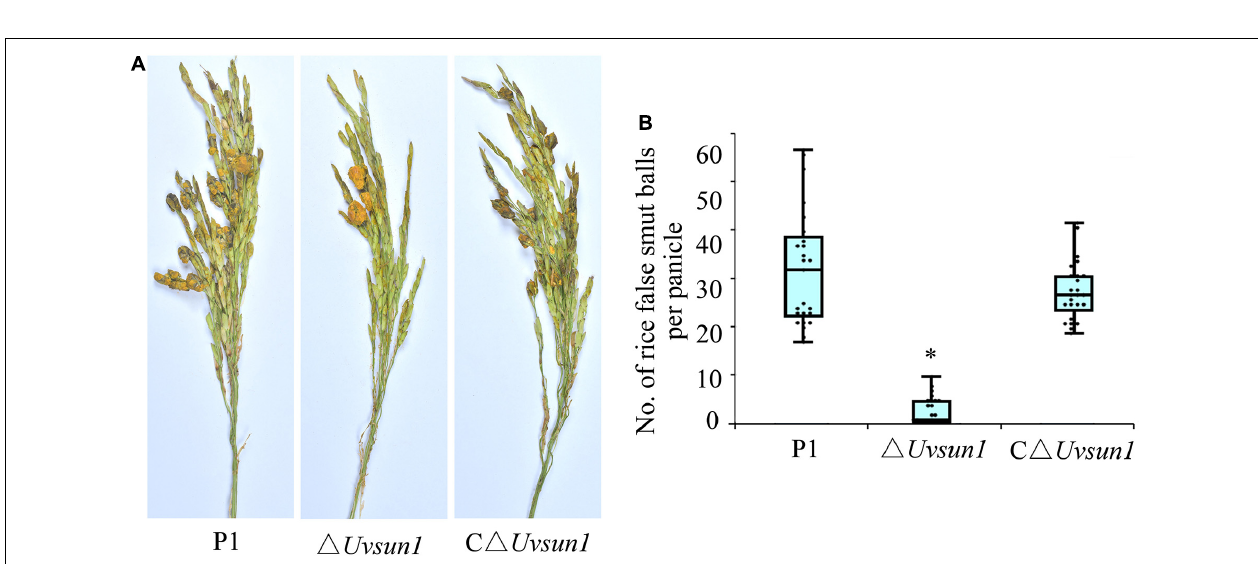
FIGURE 5 | Uvsun1 is required for Ustilaginoidea virens full pathogenicity in rice. (A) Rice spikelets were infected with an inoculum of P1, (cid:77) Uvsun1 and C (cid:77) Uvsun1 strains. Pictures were taken 21 days post-inoculation. (B) Quantification of false smut balls per infected panicle. The data were collected from three independent experiments, with a total of at least 25 panicles per line. Asterisks indicate significant differences (one-way ANOVA, ∗ p < 0.05).